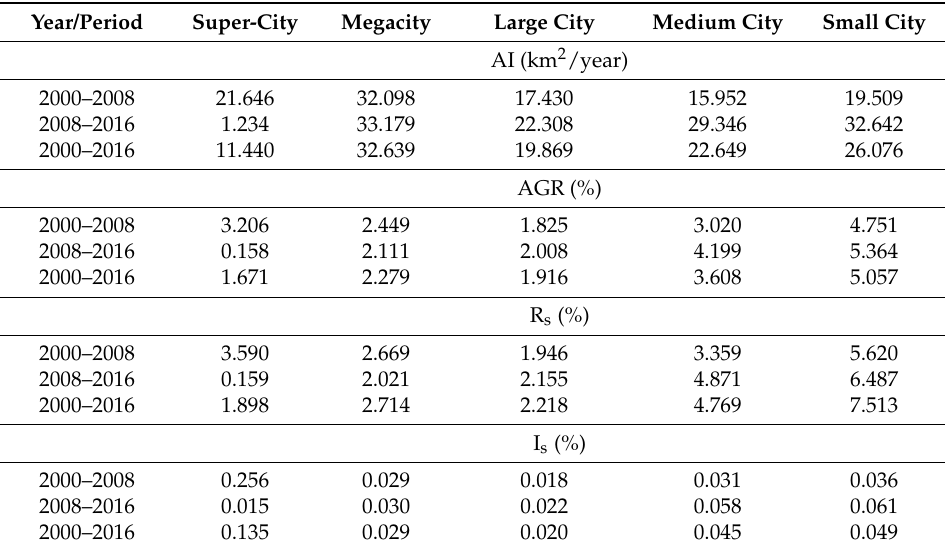
Table 5. Magnitude of urban expansion in the MYRB urban agglomeration for the five categories of cities.